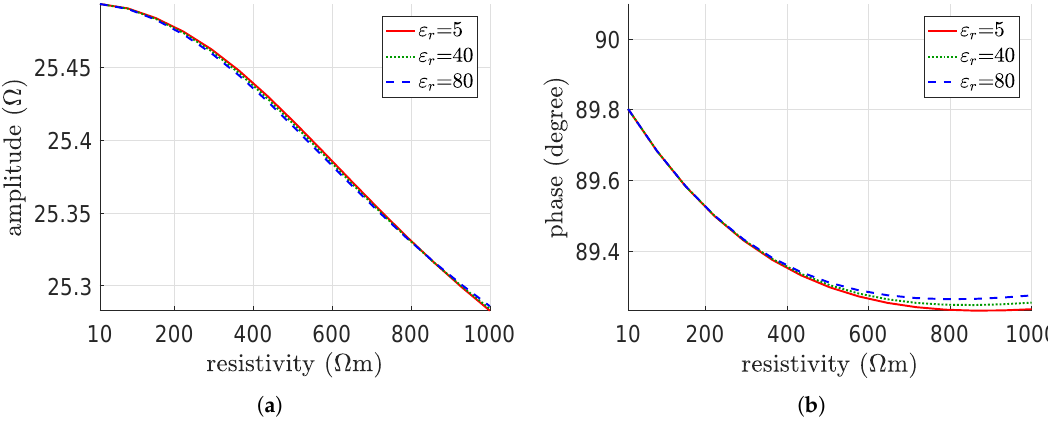
Figure 15. Equivalent impedance of the embedded coil ( Mod1 ) at 20 kHz for a concrete resistivity from 10 Ω m to 1000 Ω m, parametrized for ε r equal to 5, 40, and 80. Amplitude ( a ); phase ( b